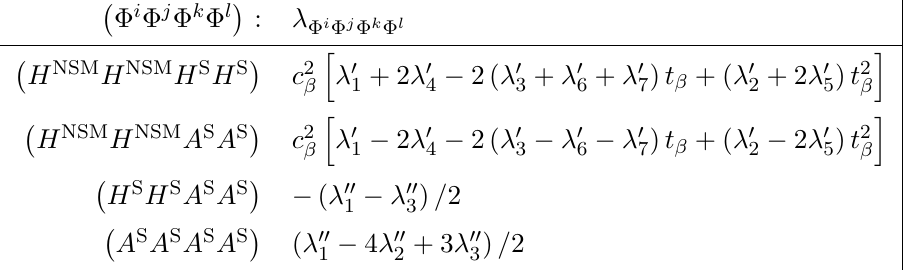
Table 2 . Independent quartic couplings in the extended Higgs basis.